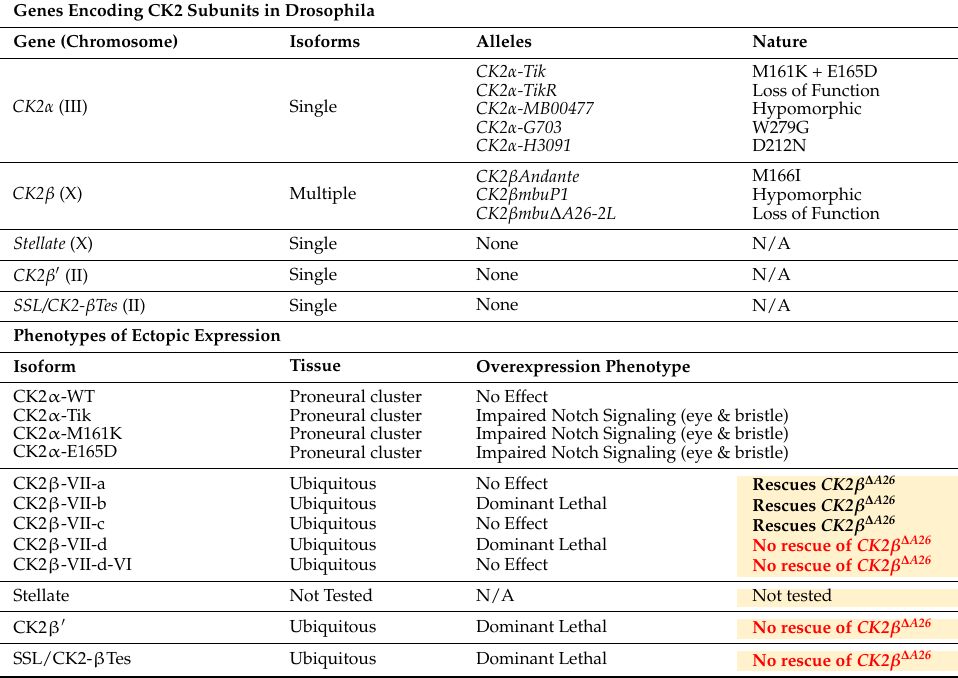
Table 2. Subunit diversity and non-redundancy of Dm-CK2 β